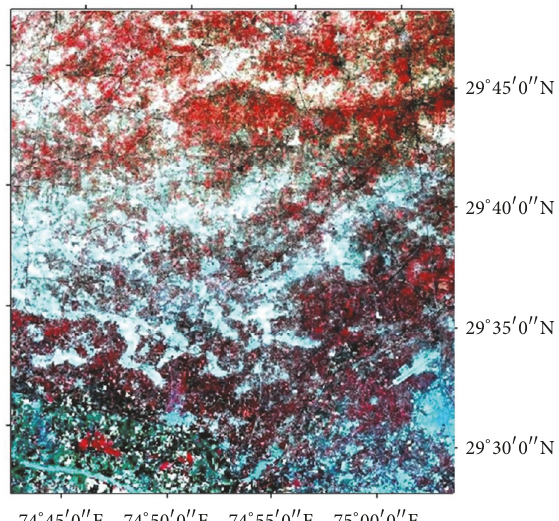
Figure 2: LANDSAT-ETM5+ false color composite map showing area affected by aeolian sand (in bright color, tones, and textures).